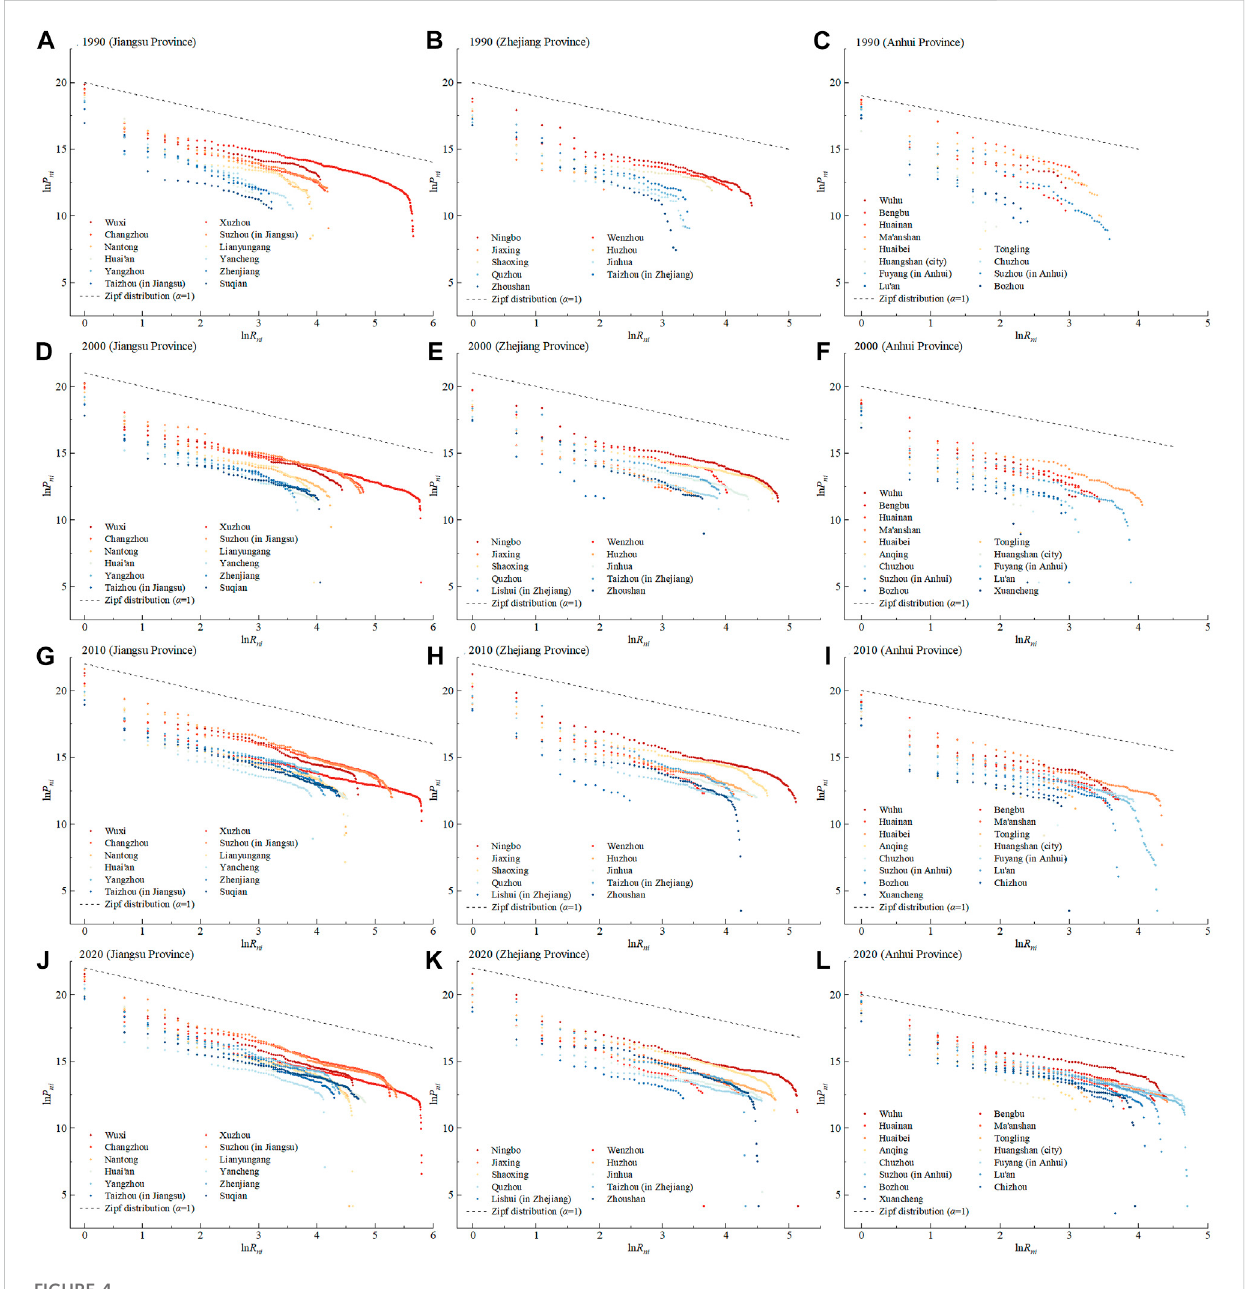
FIGURE 4 Intra city-size distribution of YRDR (prefecture-level